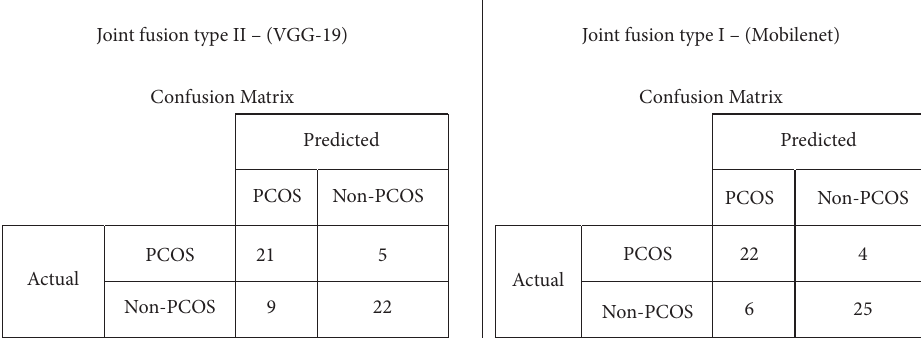
Figure 7: Confusion matrix of the best fusion model of types I and II.